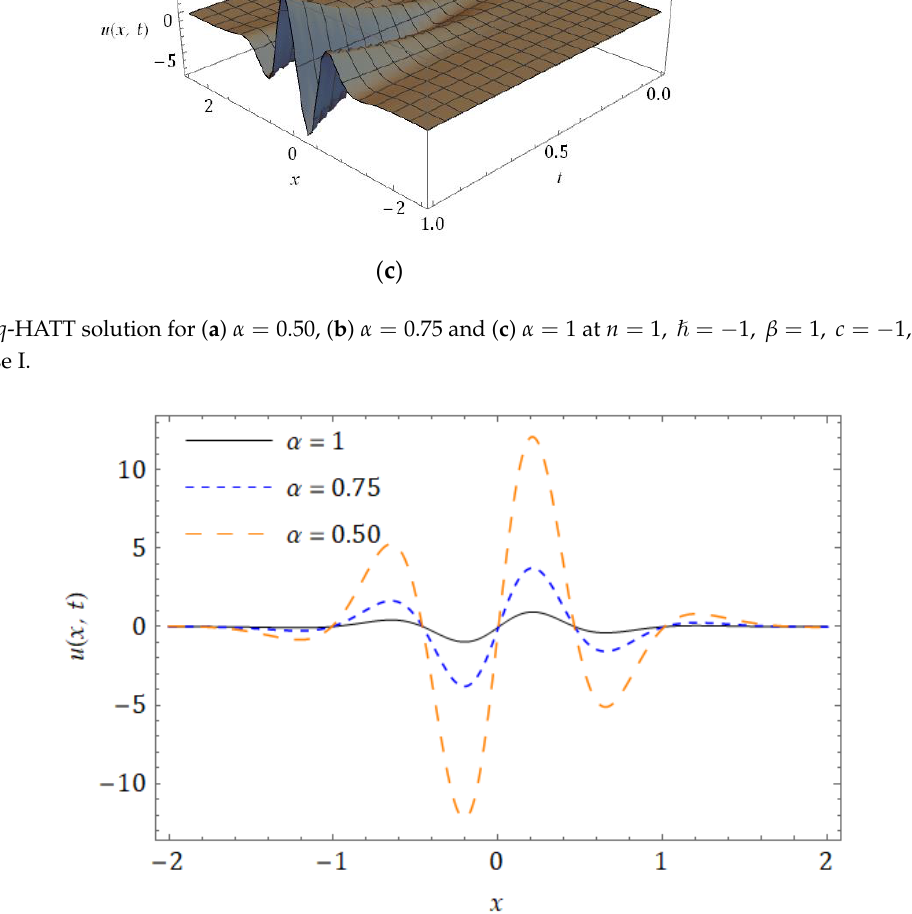
Figure 2. Response of the obtained solution with distinct 𝛼 and time at 𝑛 = 1, 𝑡 = 0.5, ℏ = −1,𝛽 = 1, 𝑐 = −1, 𝜅 1 = 1 and 𝜌 = 0.001 for Case I.